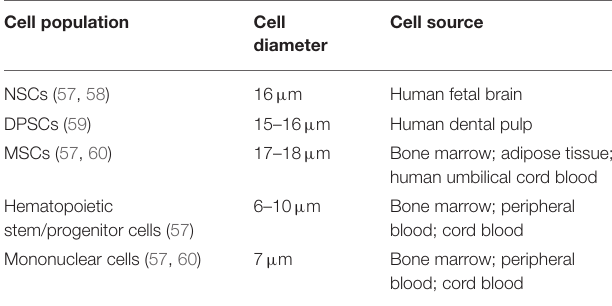
TABLE 2 | Overview of cell size of cell